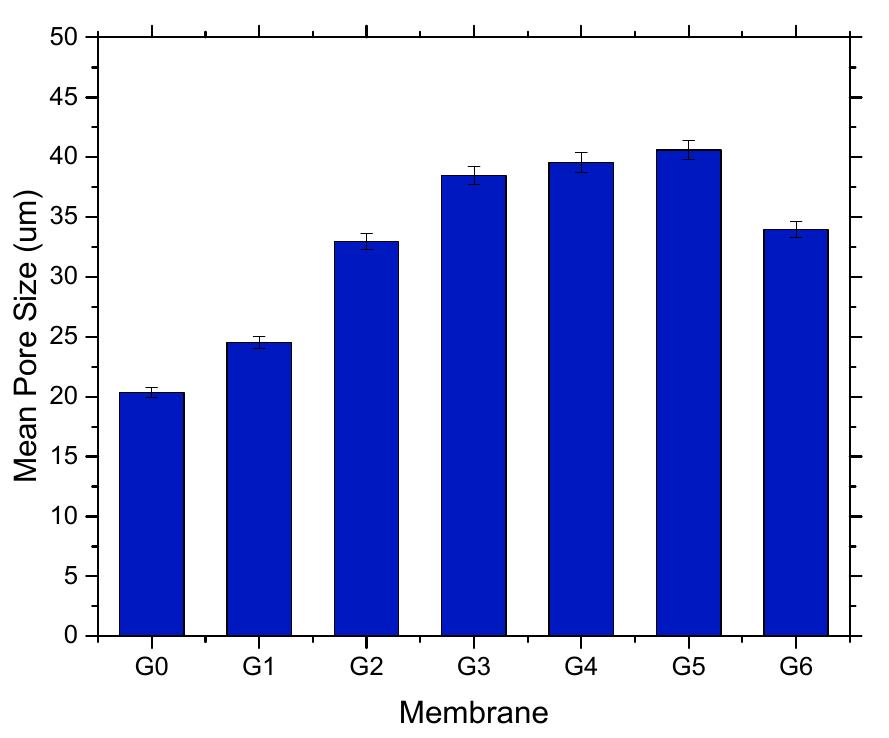
Figure 9. The pore size of the PES/TGF membranes with different contents of TGF nano-polymer.